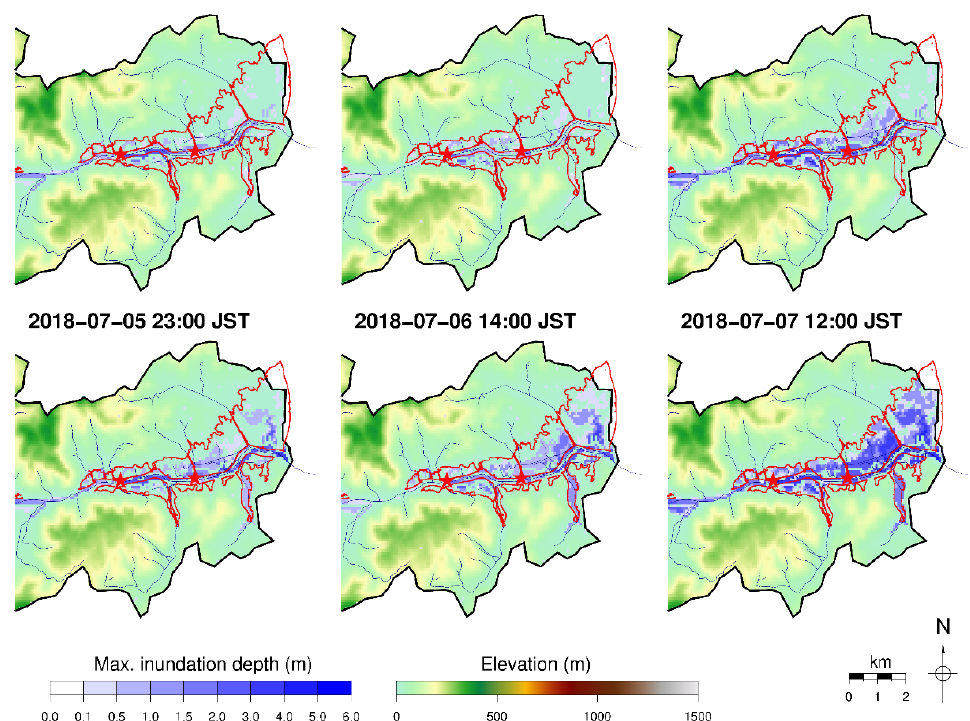
Figure 10. Simulated maximum inundation depth profiles over the Mabicho district in Kurashaki city (Okayama prefecture) during different periods. The upper profiles indicate normal conditions while the bottom panels show the effects of the back-water phenomenon and embankment bursting along the Oda river. Red polygons indicate the estimated flood area based on the GSI maps.